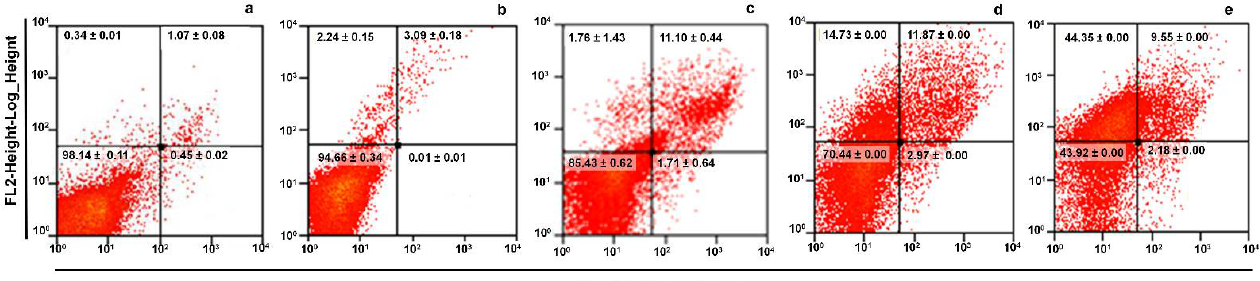
Figure 5. Necrotic effect of linearolactone LL on G. intestinalis trophozoites. Strain WB trophozoites were untreated ( a ), treated with DMSO ( b ) and exposed to LL at IC 25 ( c ), IC 50 ( d ) and IC 100 ( e ) (then colored with annexin V-FITC/PI and analyzed by FCM. Histograms are shown (R1 = necrosis; R2 = like late apoptosis; R3 = unstained protozoa; R4 = early apoptosis).